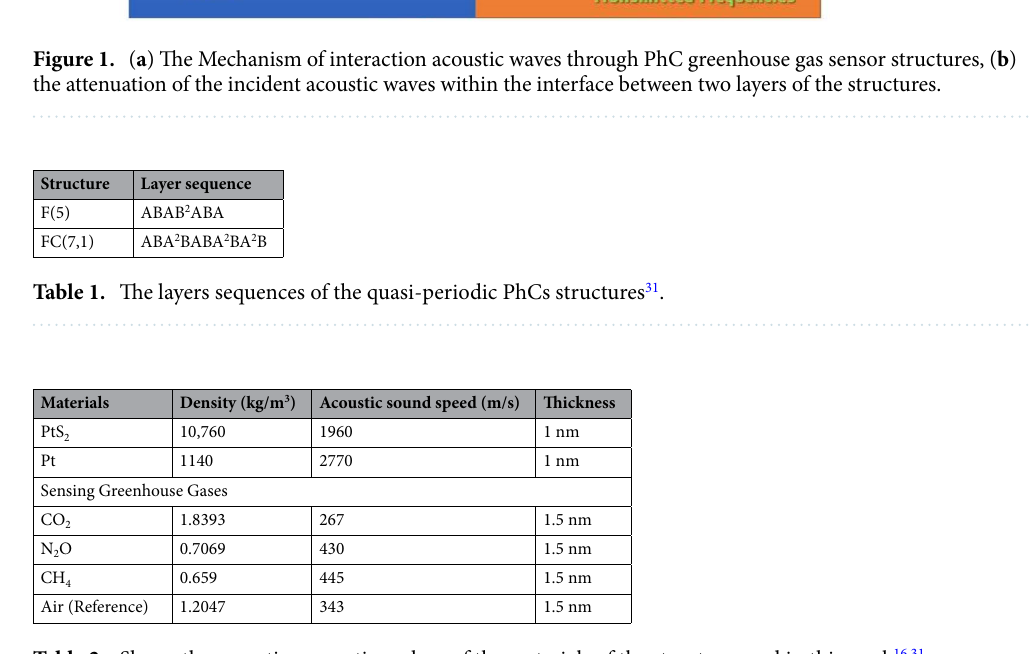
Table 2. Shows the acoustic properties values of the materials of the structure used in this work 16,31